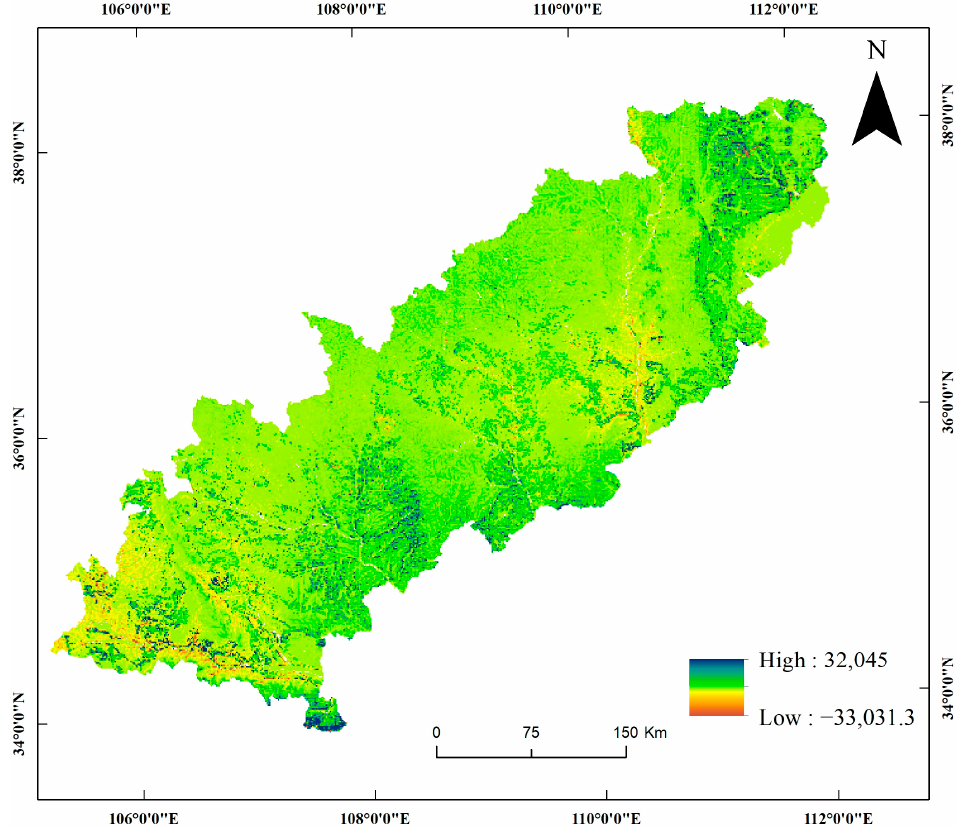
Figure 16. Distribution of changes in soil conservation services in the Loess Plateau Ecological Screen from 2005 to 2015.